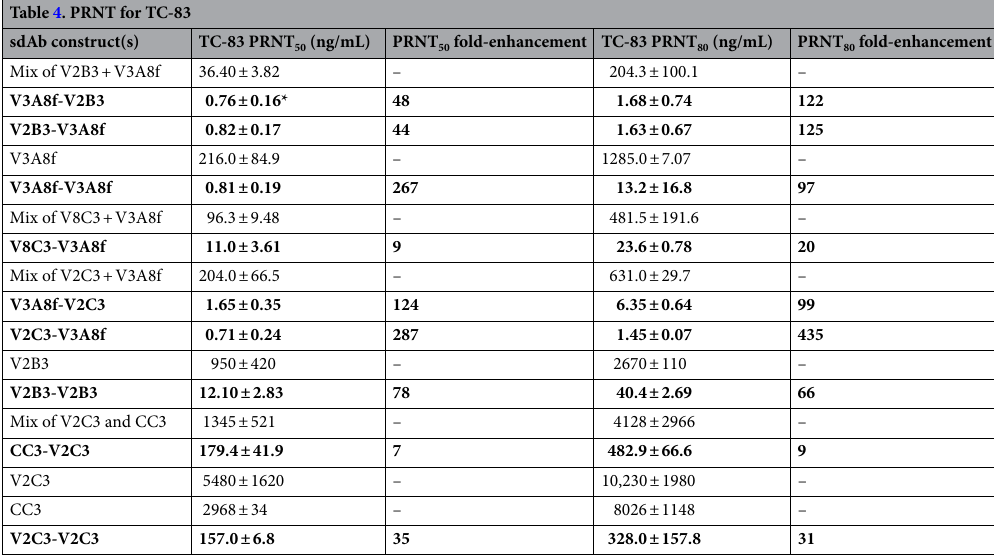
Table 4. PRNT for